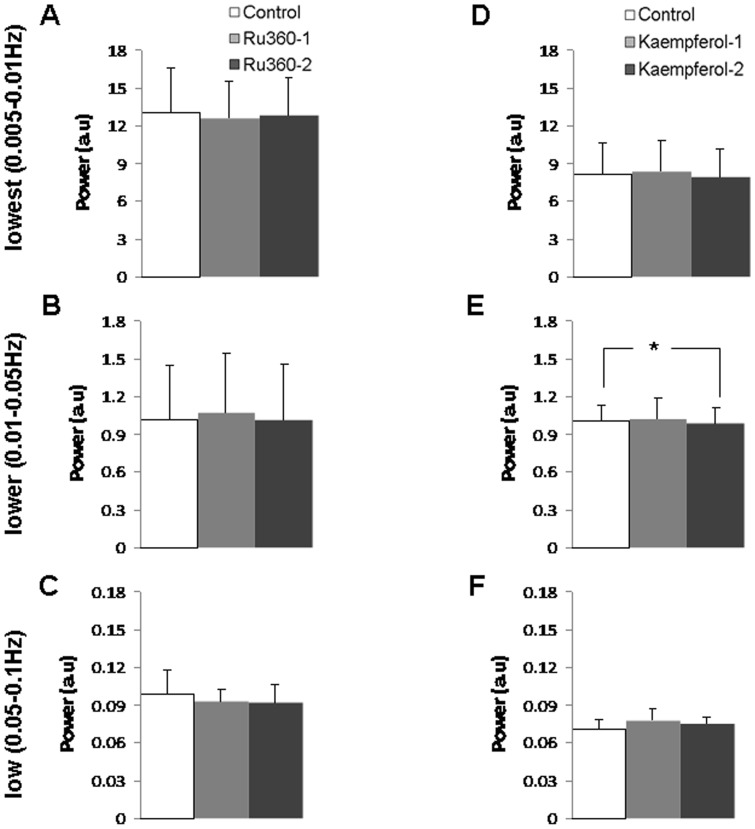
mCU modulation did not have a significant impact on the spectral power of the low frequency (<0.1 Hz) cortical CBF fluctuations.Inhibition of mCU activity with Ru360 (dose-1 = 120 µg/kg; dose-2 = 240 µg/kg) did not affect the CBF spectral power in three different low frequency bands A. lowest (0.005–0.01 Hz) B. lower (0.01–0.05 Hz) and C. low (0.05–0.1 Hz). Enhancement of mCU activity with Kaempferol (dose-1 = 1 mg/kg; dose-2 = 2 mg/kg) reduced the CBF spectral power only in the E. lower (0.01–0.05 Hz) frequency band with no significant effect on the D. lowest (0.005–0.01 Hz) and F. low (0.05–0.1 Hz) frequency bands. Significantly different *P<0.05; Kolmogorov-Smirnov test. Error bars represent the group standard deviation.